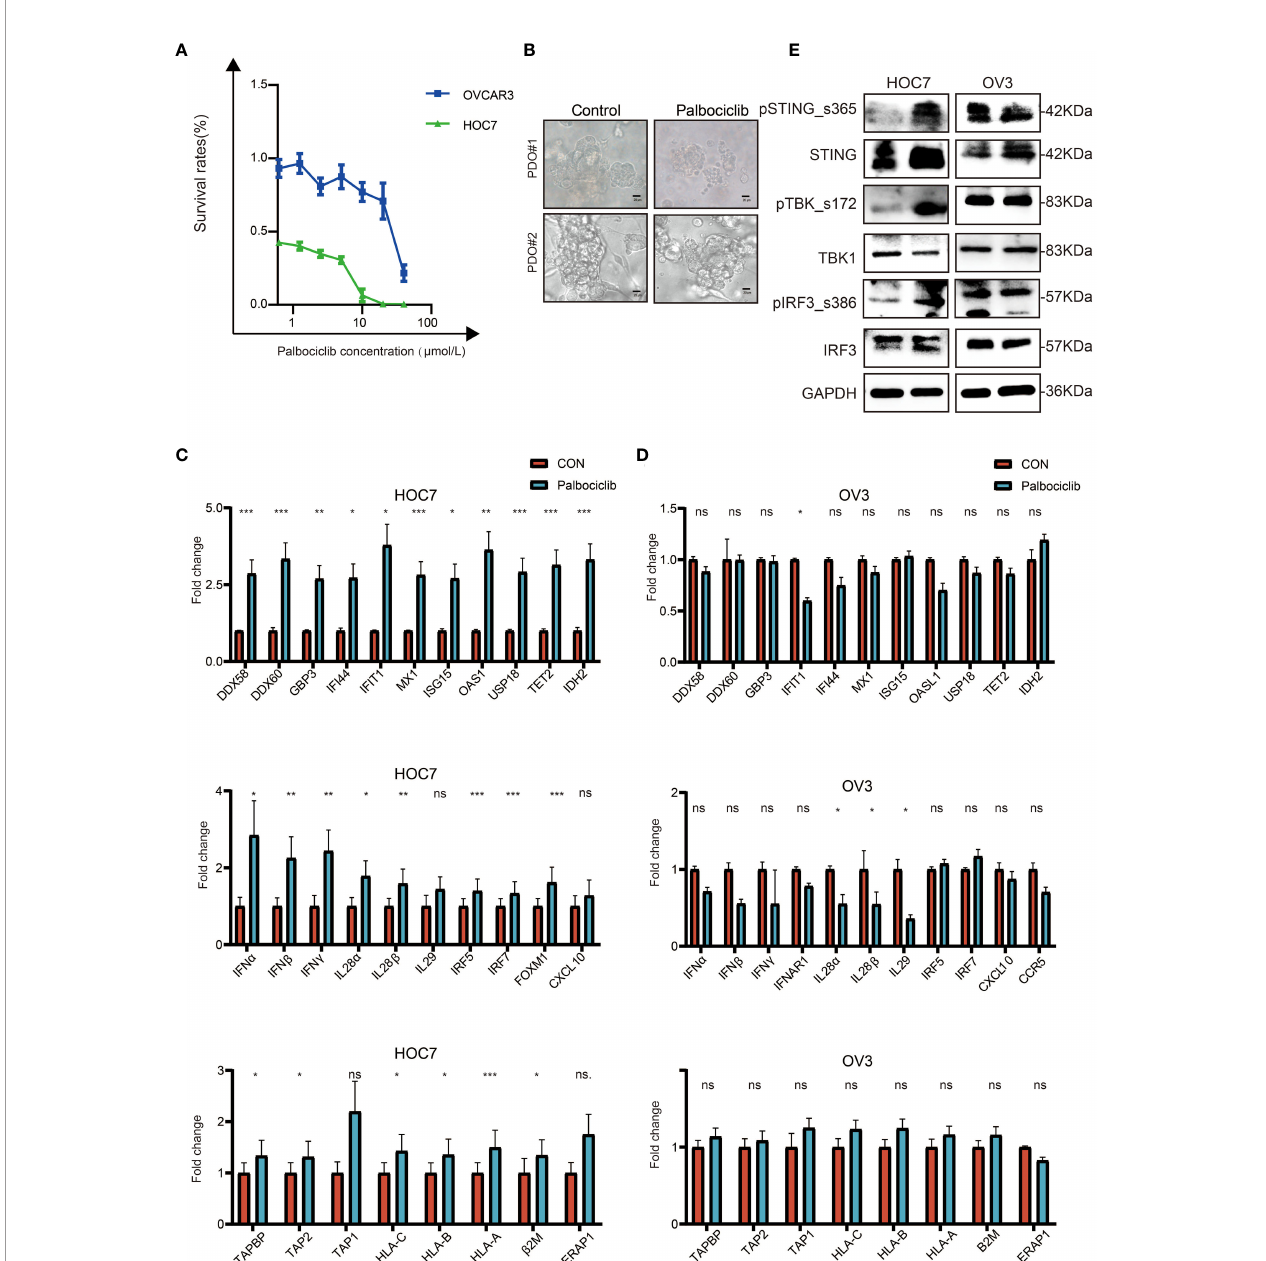
FIGURE 6 | CDK4/6 inhibitor palbociclib exerts anti-tumor effect by activated immune in OC cell lines. (A) Cell viability in response to treatment with Palbociclib in OC cell lines. (B) Representative images of white light in PDO#1 and PDO#2 from OC were treated with Vehicle, 8 m M Palbociclib for 5 days, scale bars: 20 m m. (C) QRT-PCR analysis of ISG, IFN, and antigen-presented pathway in ID8 treated with Vehicle, 5 m M Palbociclib for 48 h. The p values were calculated using the Student t-test: ns as nonsense, *P < 0.05, **P < 0.01, ***P < 0.001. (D) QRT-PCR analysis of ISG, IFN, and antigen-presented pathway in OVCAR3 treated with Vehicle, 5 m M Palbociclib for 48 h. The p values were calculated using the Student t-test: ns as nonsense, *P < 0.05, **P < 0.01, ***P < 0.001. (E) Palbociclib-sensitive (ID8) and de novo Palbociclib-resistant (OVCAR3) OC cell lines were subjected to western blot analysis for STING pathway and GAPDH as a loading